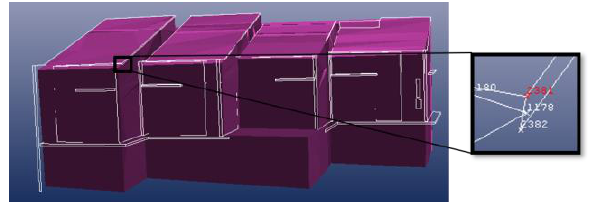
Figure 17. The location of the point that has the highest RMSE value